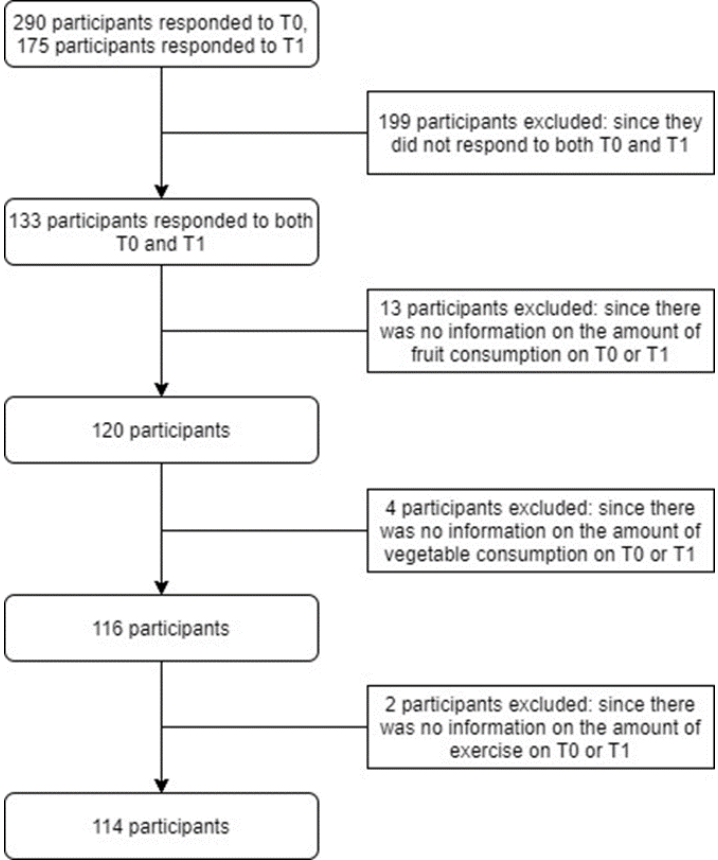
Figure 1. Flowchart of study population.